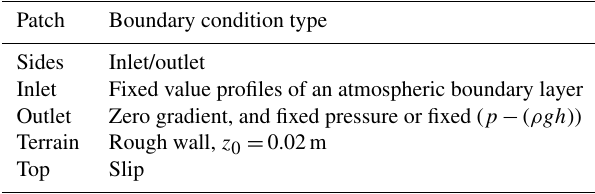
Table 1. Overview of boundary conditions applied in the neutral simulation